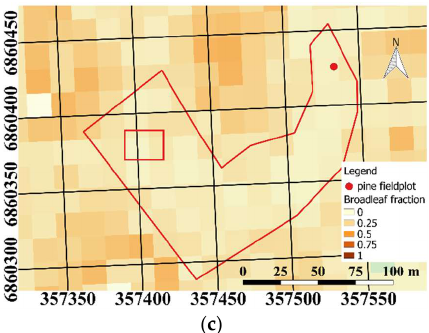
Figure 2. ( a ) A false color (red: 858 nm, green: 649 nm, blue: 547 nm) image of the selected Scots pine plot marked by the red border; ( b ) Scots pine biomass fraction map; ( c ) Broadleaf biomass fraction map. The red dot marks the field plot measured in 2011.